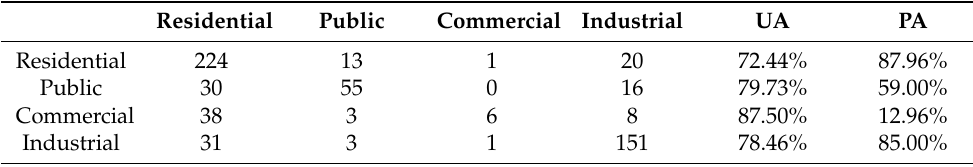
Table 11. Confusion matrix of grid and parcel exchange experiment